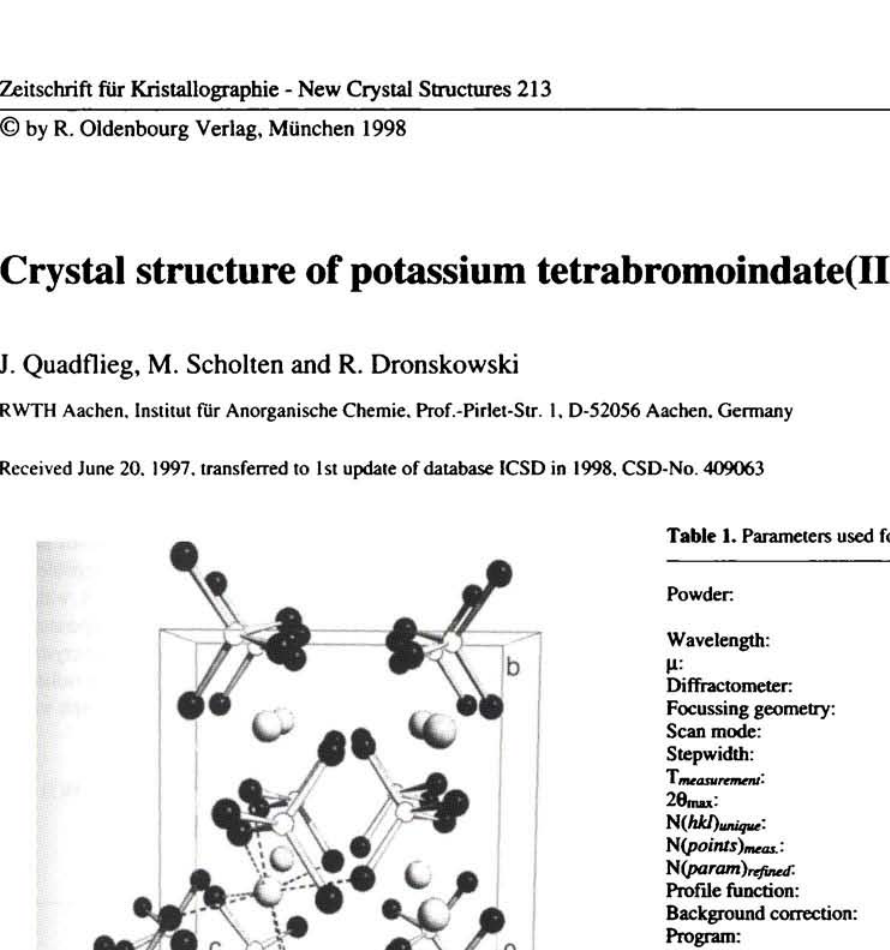
Table 2. Final atomic coordinates and displacement parameters (in